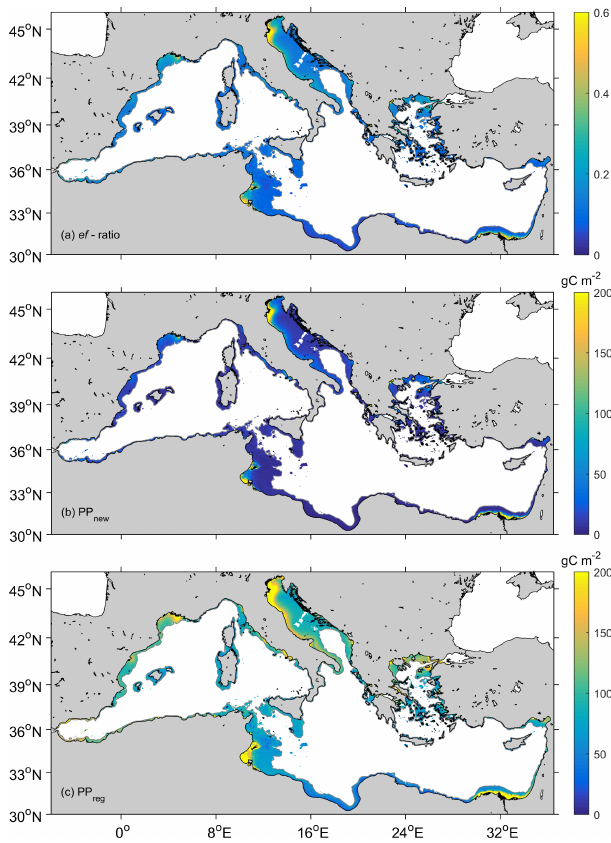
Figure 8. (a) ef -ratio in coastal waters ( < 200m) of the Mediter- ranean Sea and estimated values of (b) new (PP new ) and (c) regen- erated production (PP reg ). Mean values for the period